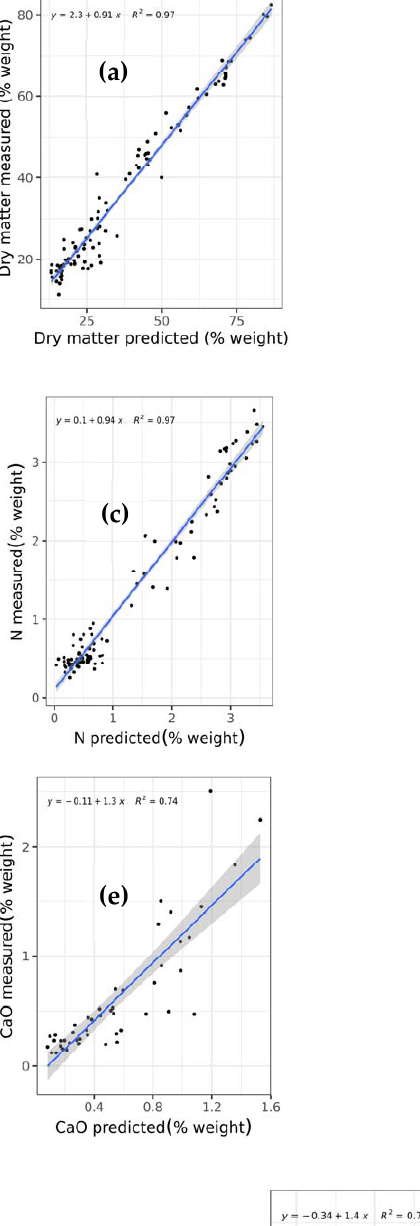
14 of 21 Table 7. Comparison of the R 2 in the testing set among the seven chemical components: dry matter (DM), total ammonium nitrogen (NH 4 ), total nitrogen (N), P 2 O 5 , CaO, MgO, and K 2 O of the fresh homogenized samples using various machine learning techniques (SVRLin = support vector regres ‐ sion with linear kernel; SVRPoly = support vector regression with polynomial kernel; SVRRad = support vector regression with radial kernel; LASSO = least absolute shrinkage and selection oper ‐ ator; RIDGE = ridge regression; ENET = elastic net regression; PLS = partial least squares; RF = ran ‐ dom forests; RPART = recursive partitioning and regression trees; XGB = boosted trees). Best results are indicated in bold. Algorithm